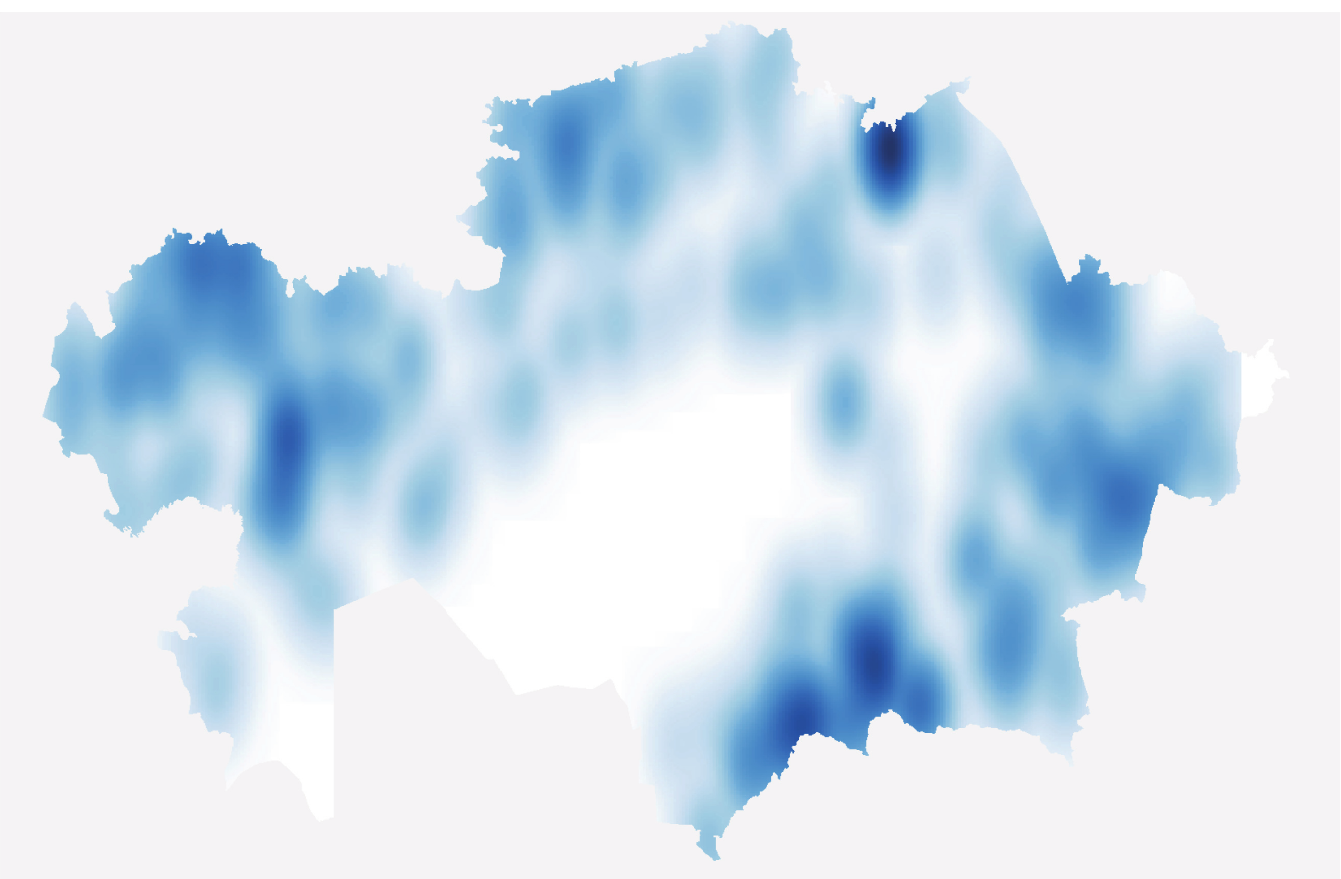
Fig 3. Kernel density estimation for cases of animal rabies in Kazakhstan between 2003 and 2013. The darker the shading indicates a higher density of rabies cases White is where there are no cases.